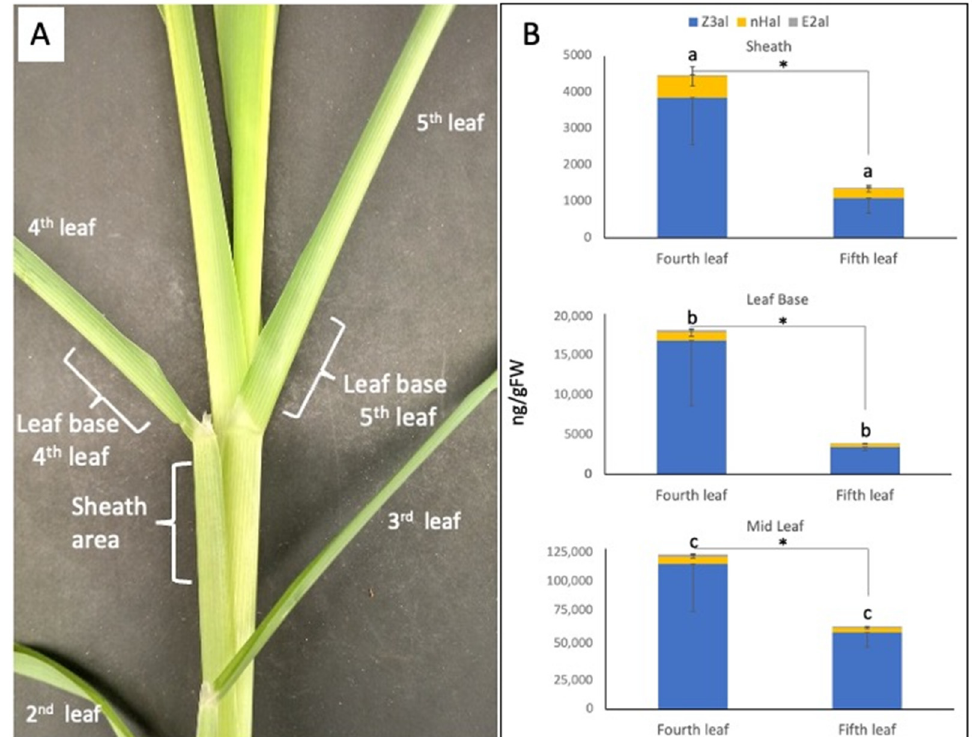
Figure 2. Distribution of the capacity to produce aldehyde GLV in a fully developed maize leaf. ( A ) A portion of a 25-day-old maize plant is shown with the segments used for the analysis marked. Note that the middle leaf blade segment is not shown. ( B ) Results for Z-3-hexenal (Z3al), n-hexanal (nHal), and E-2-hexenal (E2al) in the sheath, base, and mid-leaf area. The values are means ± SD, and the asterisk indicate significant differences between leaves (Total aldehyde GLV, Students t -test, p ≤ 0.05). Different letters indicate significant differences (ANOVA, p ≤ 0.05) in the total amount of aldehyde GLV for the comparison of segments within one leaf.